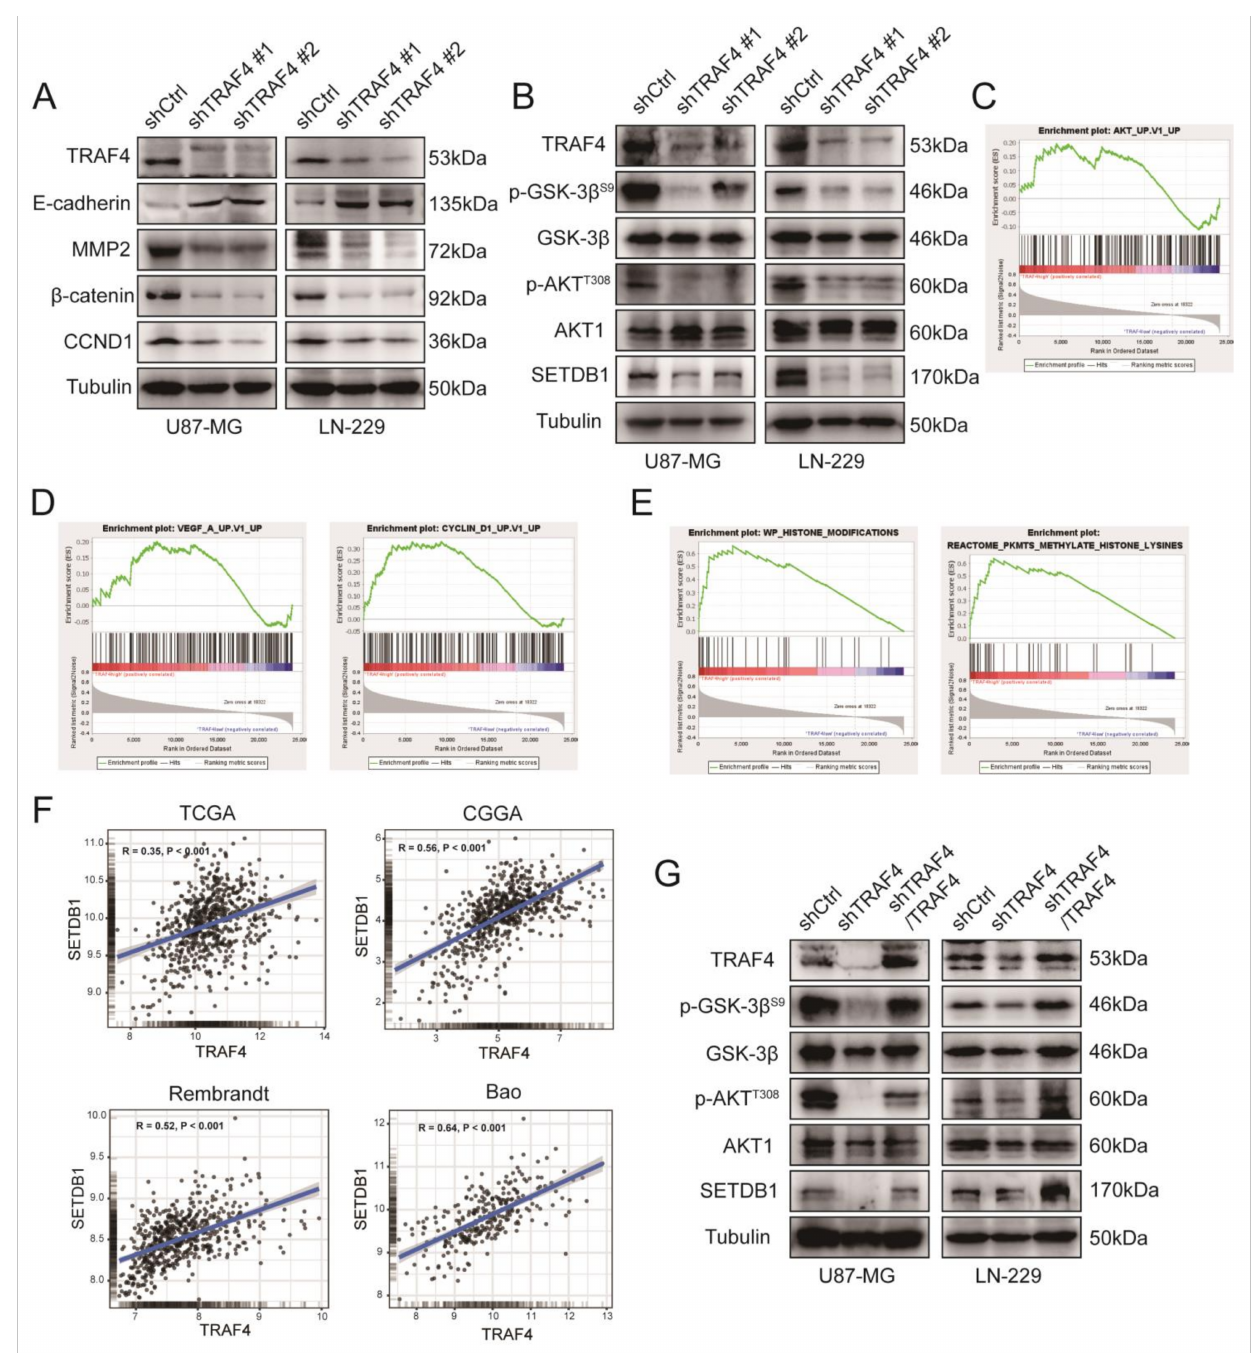
Figure 3. Downregulation of TRAF4 in glioblastoma cells inhibits cellular AKT pathway activa- tion, whereas restoration of TRAF4 expression counteracts the inhibition. ( A ) The expression of glioblastoma cell growth and metastasis-related proteins was detected by Western blotting following TRAF4 knockdown. ( B ) AKT pathway activation-related protein expression in glioblastoma cells were detected following TRAF4 knockdown. ( C ) In GSEA, enrichment analysis of TRAF4 and AKT pathway gene sets. ( D ) Enrichment analysis of TRAF4 and cell metastasis-related gene sets and CCND1-related gene sets. ( E ) Enrichment analysis of TRAF4 and histone modification gene sets and histone lysine methylation gene sets. ( F ) Gene correlation analysis of TRAF4 with SETDB1 in glioma databases TCGA, CGGA, Rembrandt and Bao. ( G ) AKT pathway activation-related proteins expression was detected by Western blotting following TRAF4 knockdown and then overexpressed. Student’s t test was performed to analyze